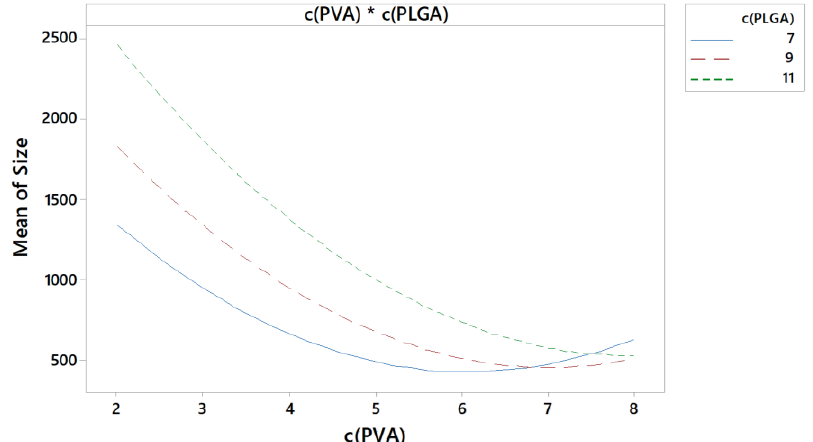
Figure 4. Interaction plot for z-average as a function of stabiliser concentration in % for 7% (blue), 9% (red) and 11% (green) PLGA.